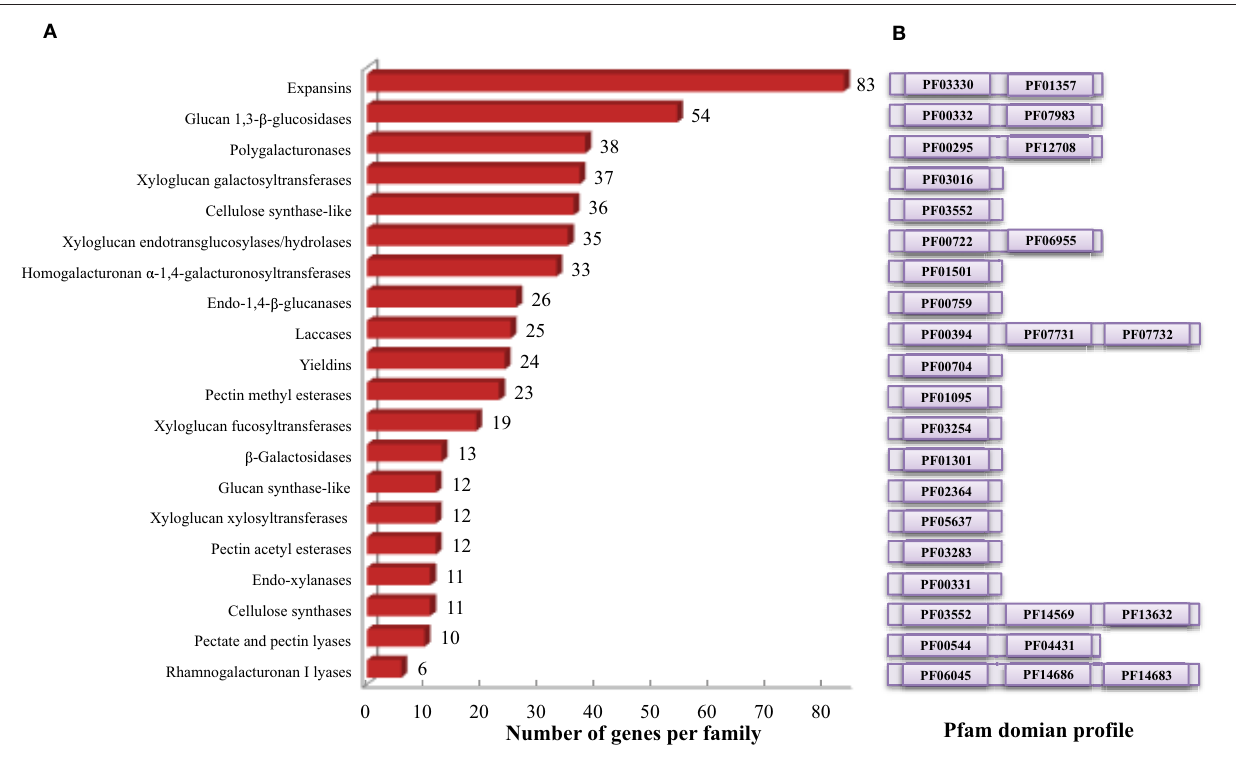
FIGURE 1 | Cell wall related gene families in sorghum. (A) Distribution of identified cell wall related genes among various gene families. (B) Family specific pfam domains used to identify cell wall related genes using